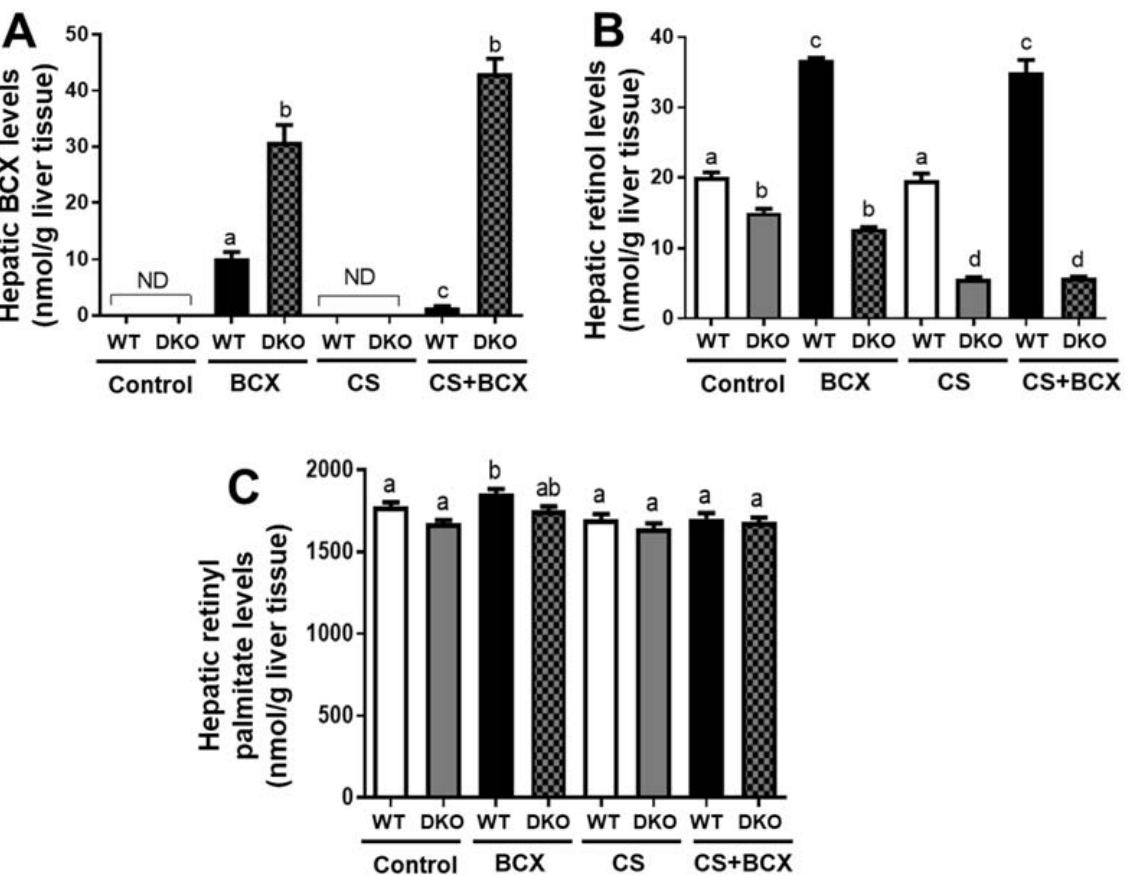
Figure 1. Hepatic BCX, retinol, and retinyl palmitate in WT and BCO1 − / − /BCO2 − / − DKO mice. Hepatic levels of ( A ) BCX, ( B ) retinol, and ( C ) retinyl palmitate in mice, detected by HPLC. Groups: Control, non-CS-exposed mice without supplementation; BCX, non-CS-exposed mice with BCX supplementation; CS, CS-exposed mice without supplementation; CS+BCX, CS-exposed mice with BCX supplementation. Significant differences between groups were analyzed by one-way ANOVA and are denoted by different letters (significance: p < 0.05). BCX, β -cryptoxanthin; CS, cigarette smoke; HPLC, high-performance liquid chromatography; WT, wild type; DKO, double knockout; BCO1, β -carotene-15,15 ′ -oxygenase; BCO2, β -carotene-9 ′ ,10 ′ -oxygenase; ND, Not detected. 2.3. Effects of BCX Supplementation on CS-Induced Inflammatory Cell Infiltration in WT and DKO